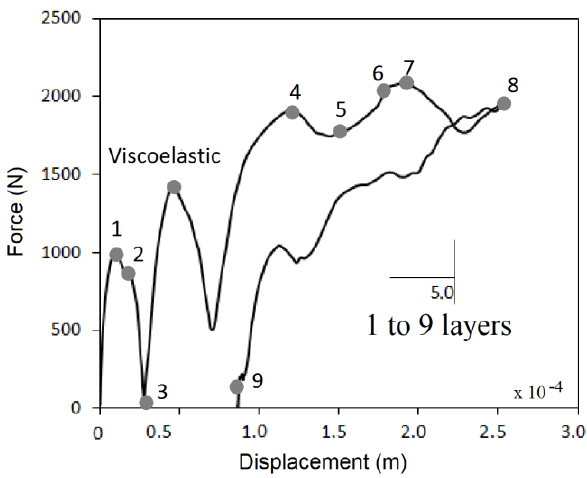
Figure 21. Comparison of the force vs. displacement diagram for an impact at 40 J in modified panel.